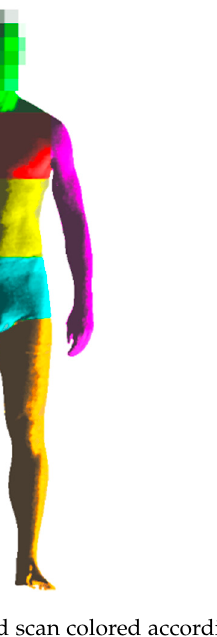
Figure 6. Three-dimensional (3D) body segmented scan colored according to the body parts (head, arms, upper/lower torso, hips, and legs.